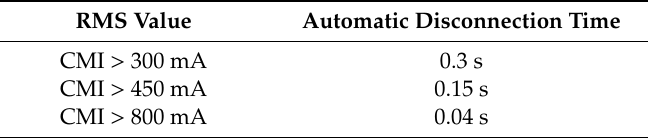
Table 1. Maximum common mode current (CMC)